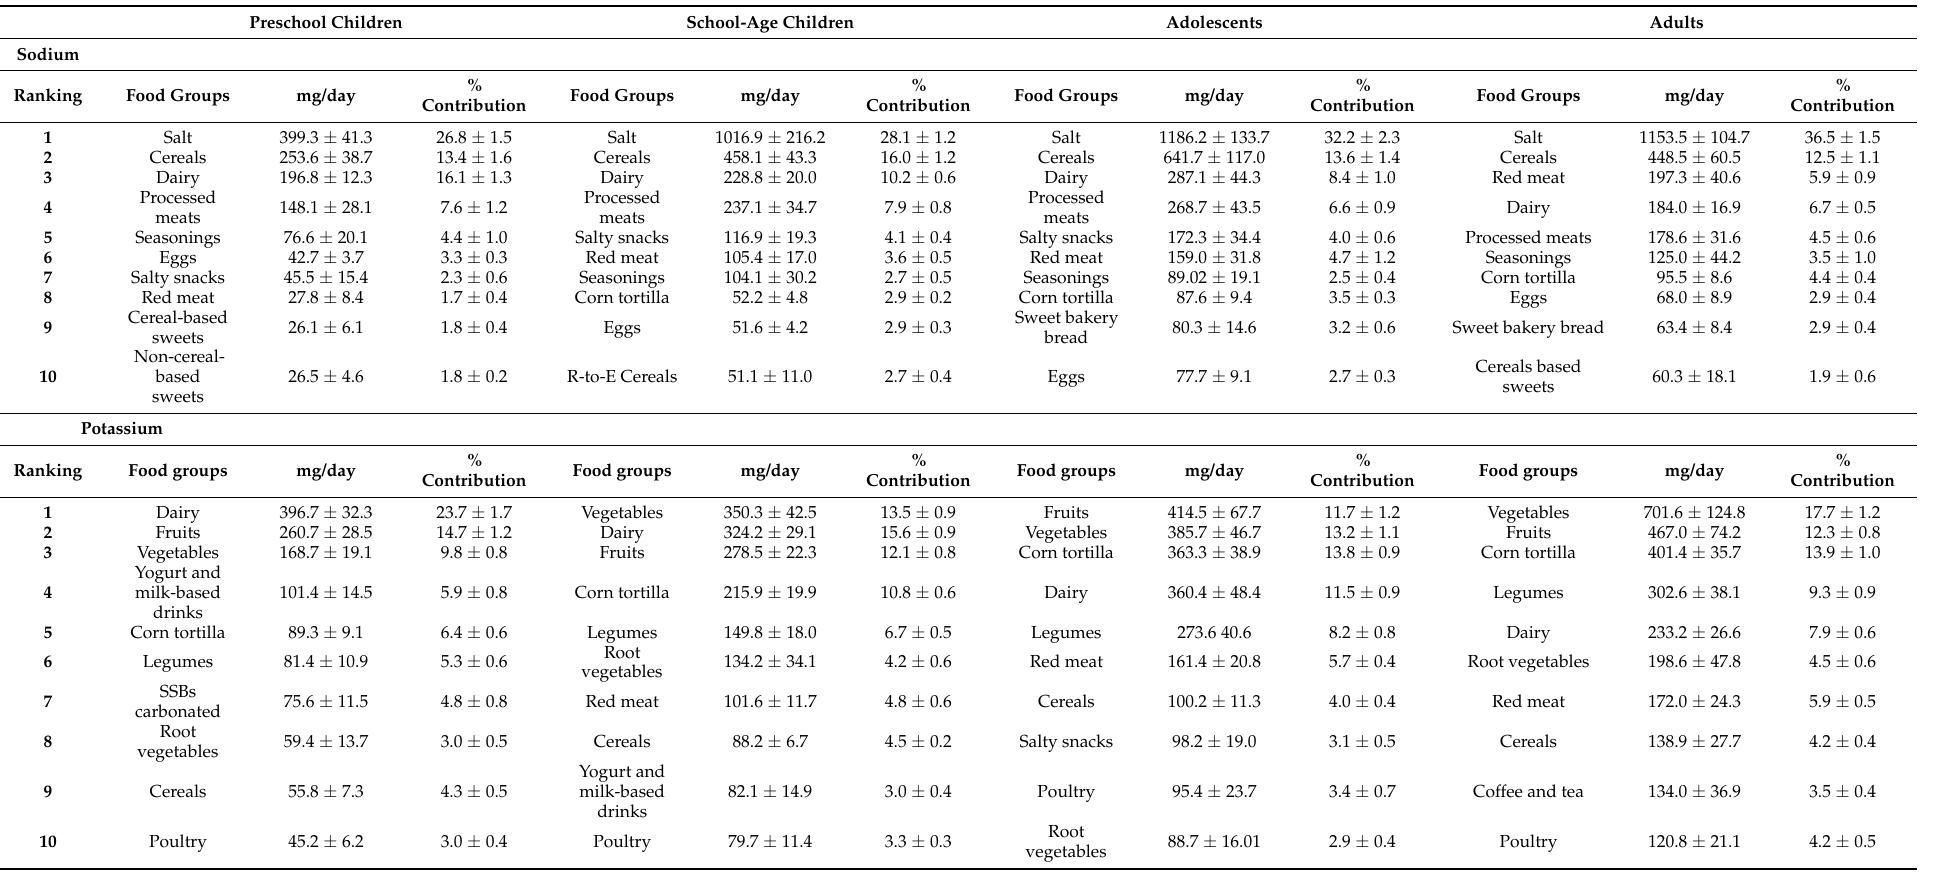
Table 2. Dietary top 10 food and beverage groups contributing to sodium and potassium intake in Mexican population: ENSANUT